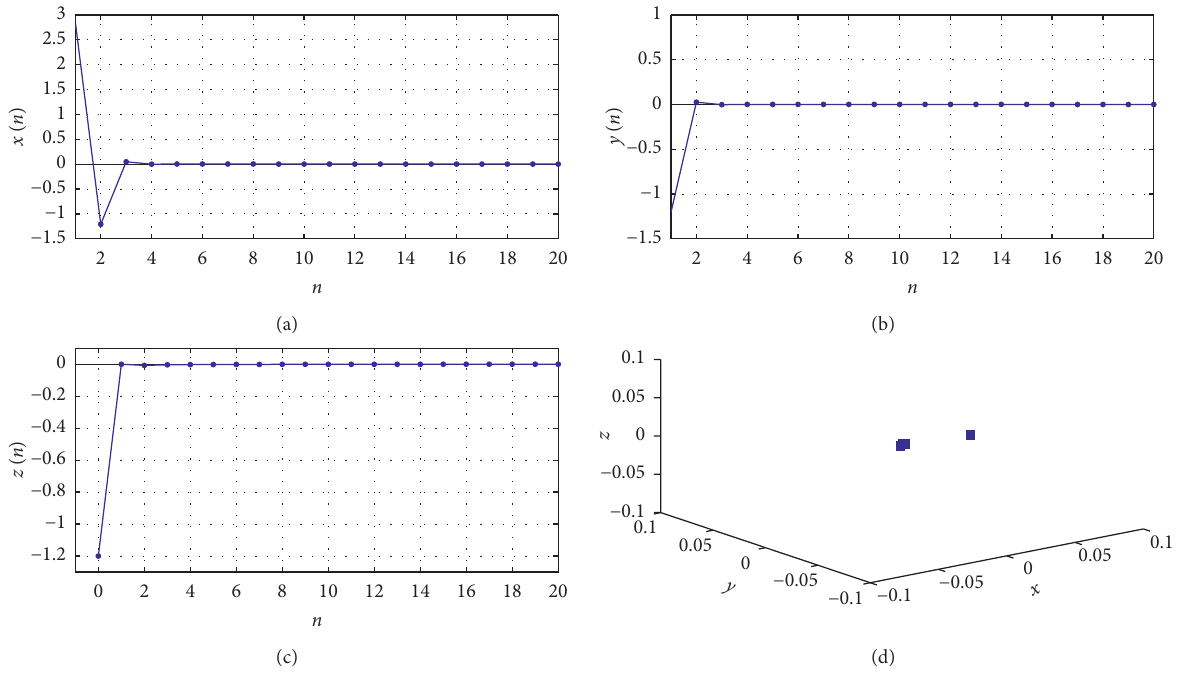
Figure 3: Stabilized states of the controlled fractional Grassi–Miller map (9) via linear control laws (10) with α � 1, β � 0 . 5, and fractional order ] � 0 .